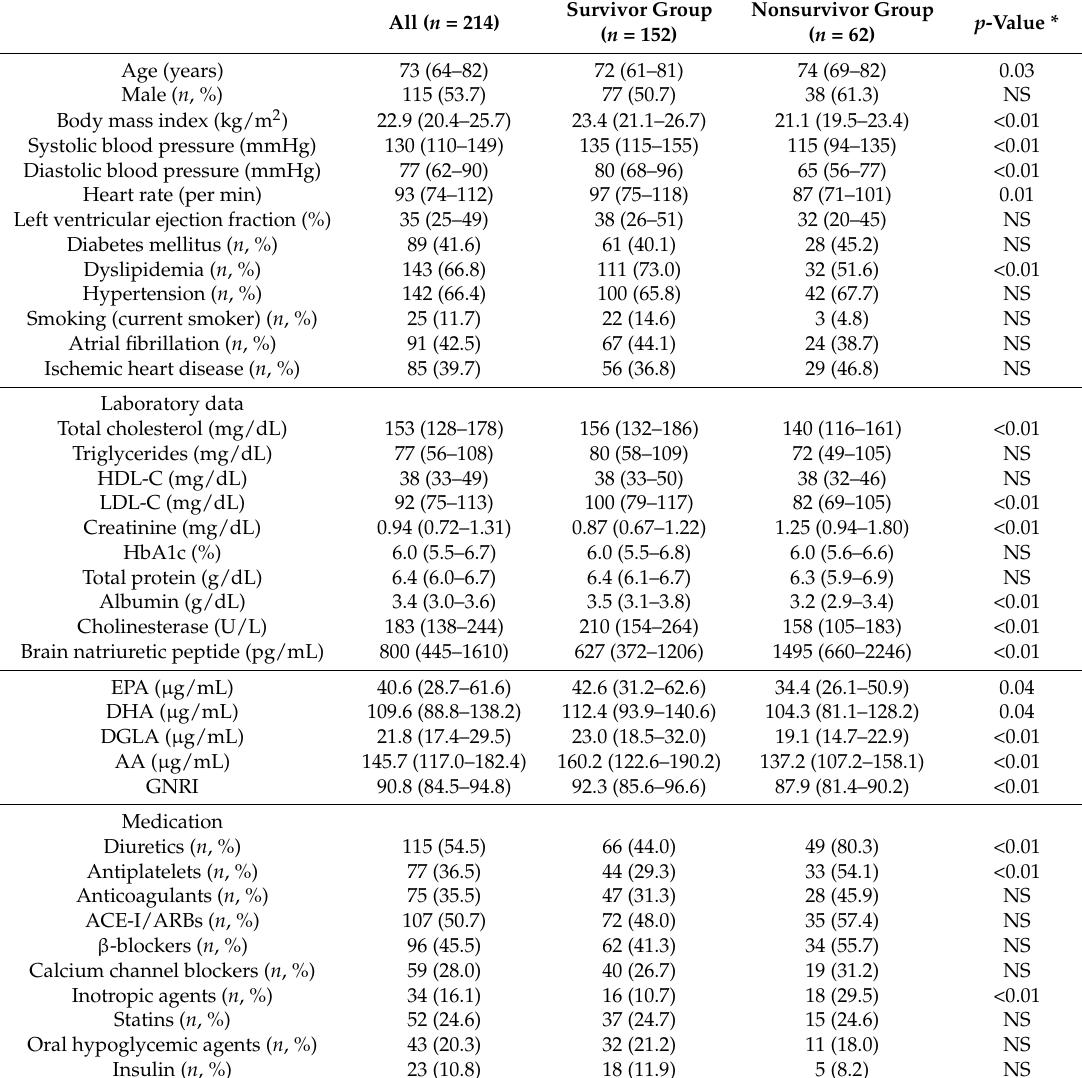
Table 1. Characteristics of the study